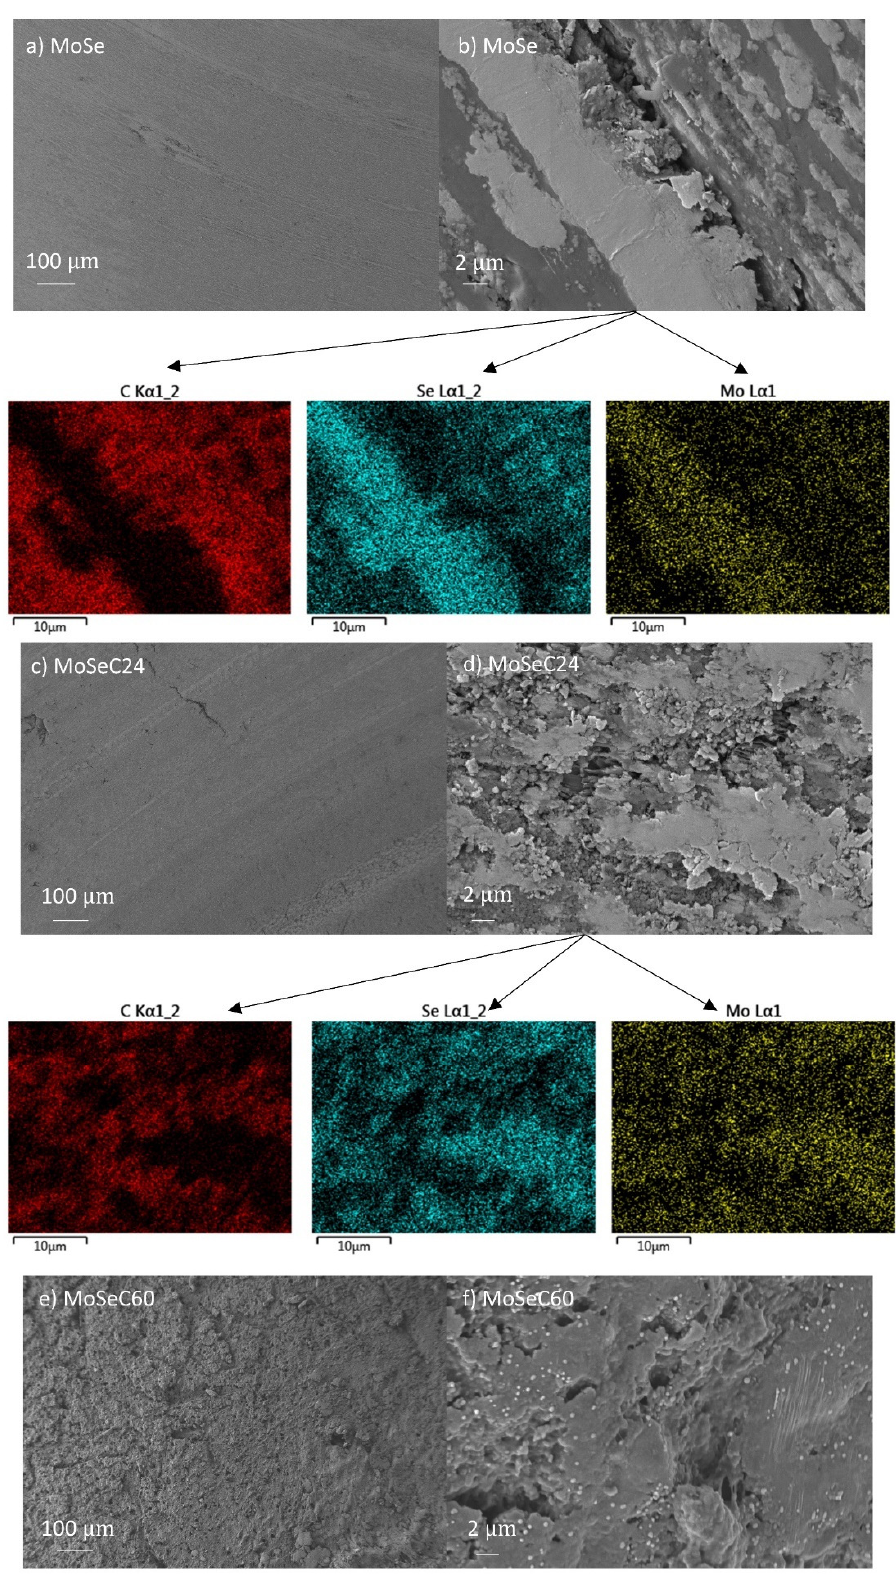
Figure 14. SEM/EDS of the rubber counterbodies performed after POD experiments at 200 °C: ( a ) for MoSe at LM; ( b ) for MoSe at HM; ( c ) for MoSeC24 at LM; ( d ) for MoSeC24 at HM; ( e ) for MoSeC60 at LM; ( f ) for MoSeC60 at HM.